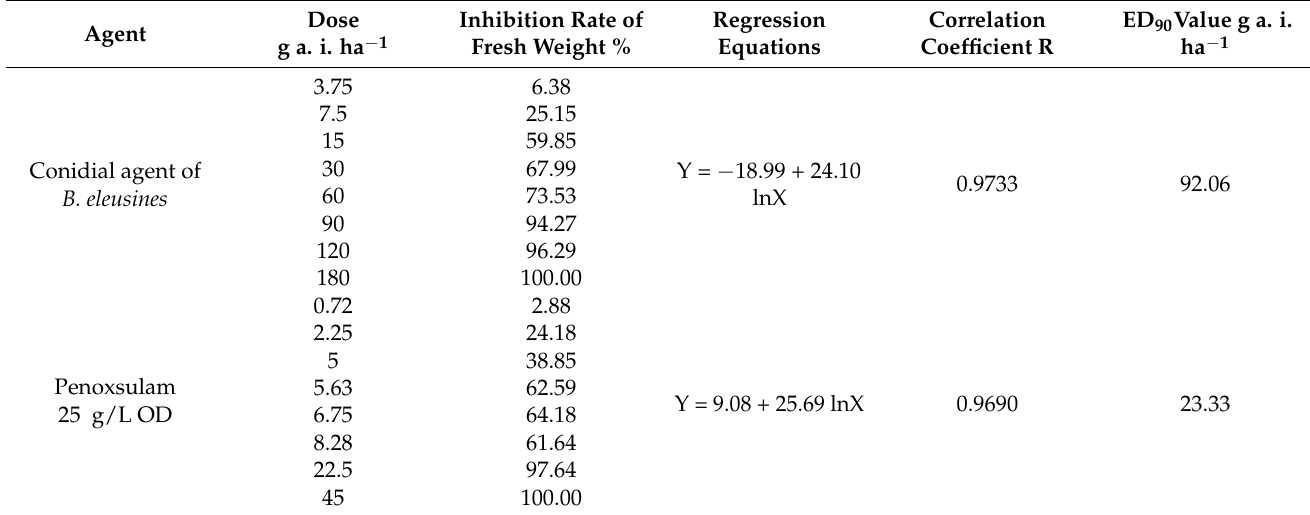
Table 3. Determination of ED 90 value of B. eleusines conidial agent and 25 g/L penoxsulam OD on